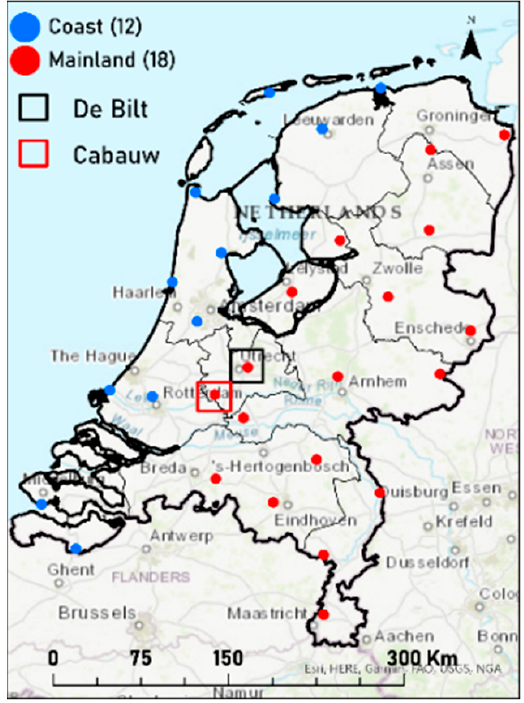
Figure 1. Royal Netherlands Meteorological Institute (KNMI) stations in the Netherlands. Stations are categorized as coast (blue dots) and mainland (red). The station in the center (black square) is the De Bilt KNMI Station, and the station in the red square is the Baseline Surface Radiation Network (BSRN) station Cabauw.